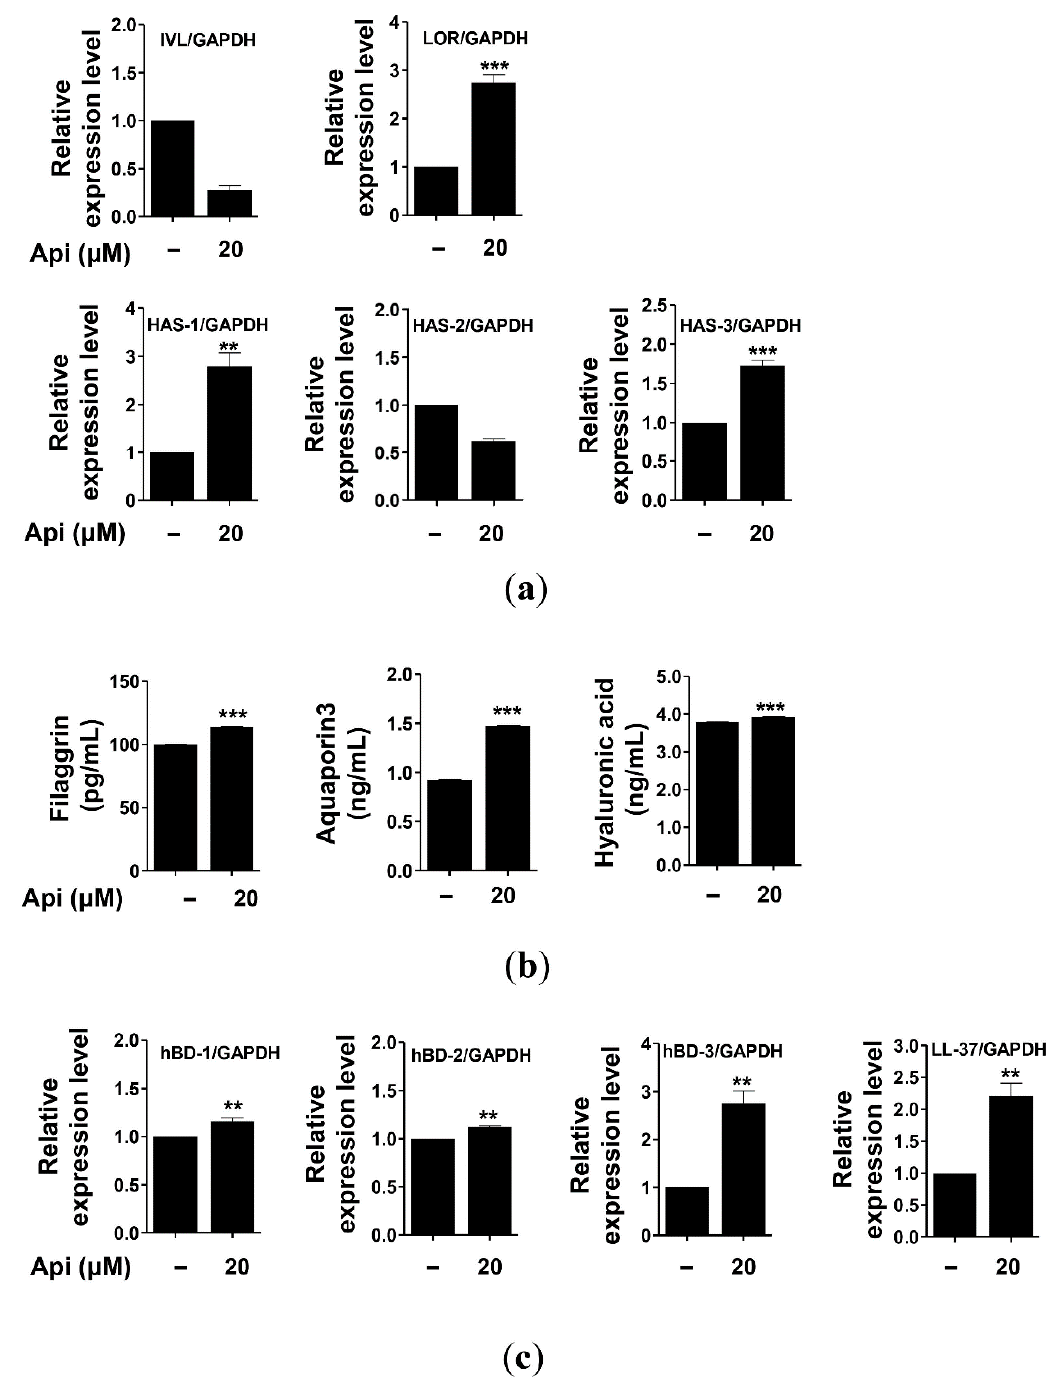
Figure 6. Effects of apigenin on the expression of the genes related to the physical barrier ( a,b ) and chemical barrier ( c ) functions of HaCaT cells. Cells were treated with apigenin (20 µ M) for 24 h. Api, apigenin; IVL, involucrin; LOR, loricrin. The data were analyzed using t -test. ** p < 0.01, *** p < 0.001 versus cells without apigenin treatment.